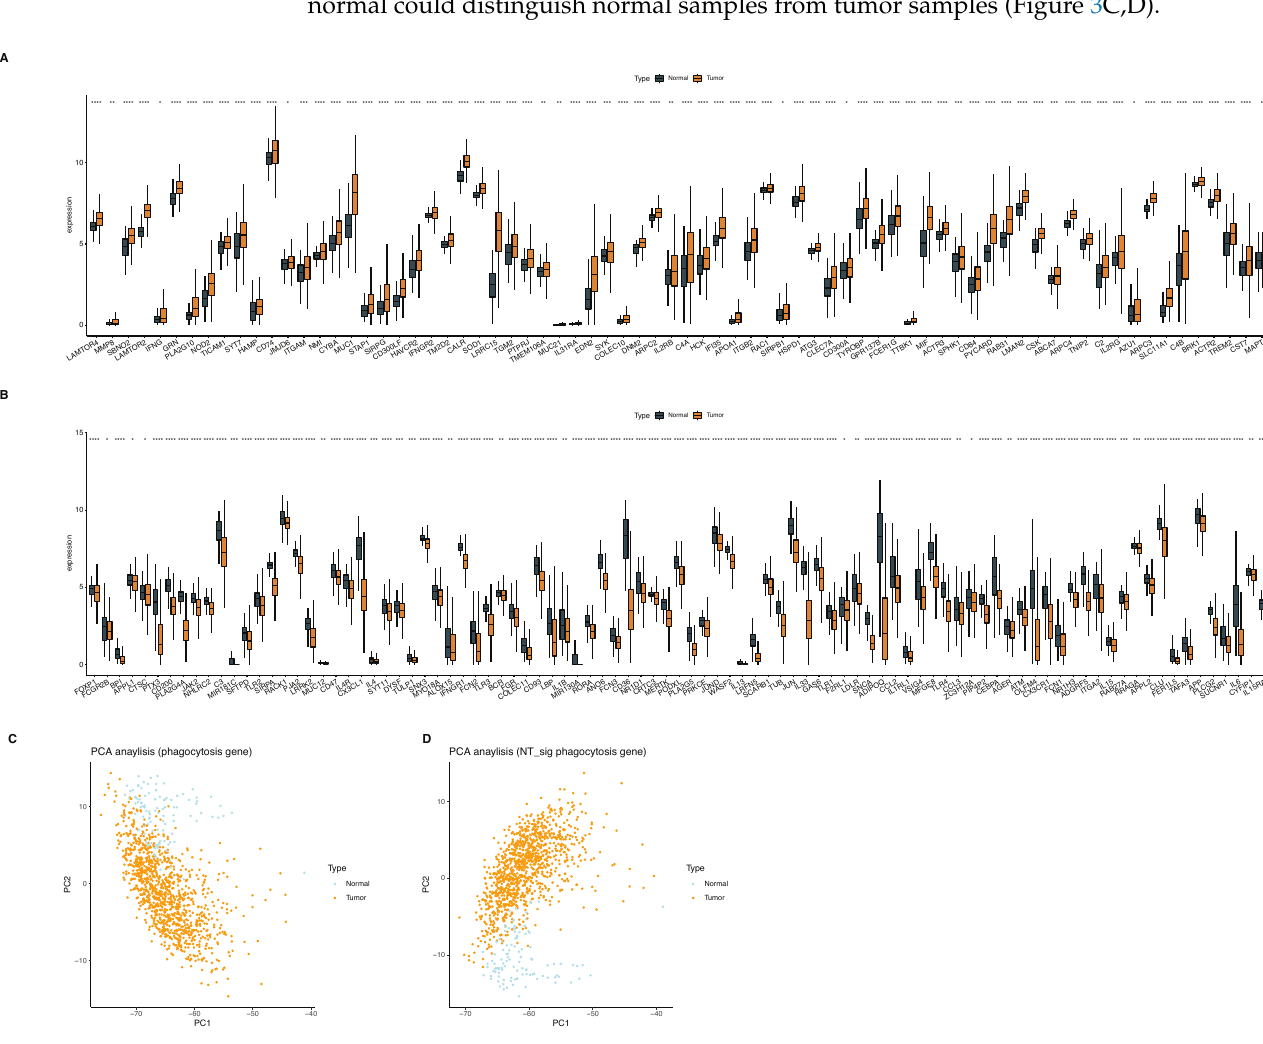
Figure 3. Differences in phagocytic factor expression between normal and tumor samples. ( A ) The expression level was higher in tumors than in normal tissues, ( B ) the expression level in normal tissues was higher than that in tumor samples, ( C ) PCA of all phagocytosis factors, and ( D ) PCA of normal and tumor differentially expressed phagocytic factors. Note, “e − number represents 10 − number ” (* p < 0.05, ** p < 0.01,*** p < 0.001, **** p <